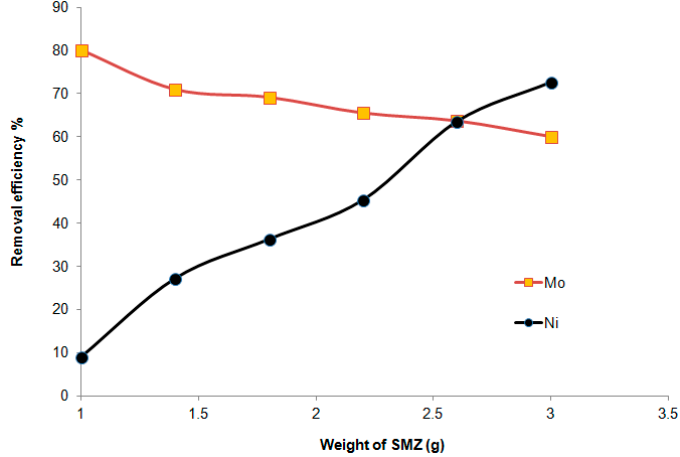
Figure 9. Mo and Ni removal efficiency by the surfactant modified phillipsite–chabazite tuff at different sample weights.